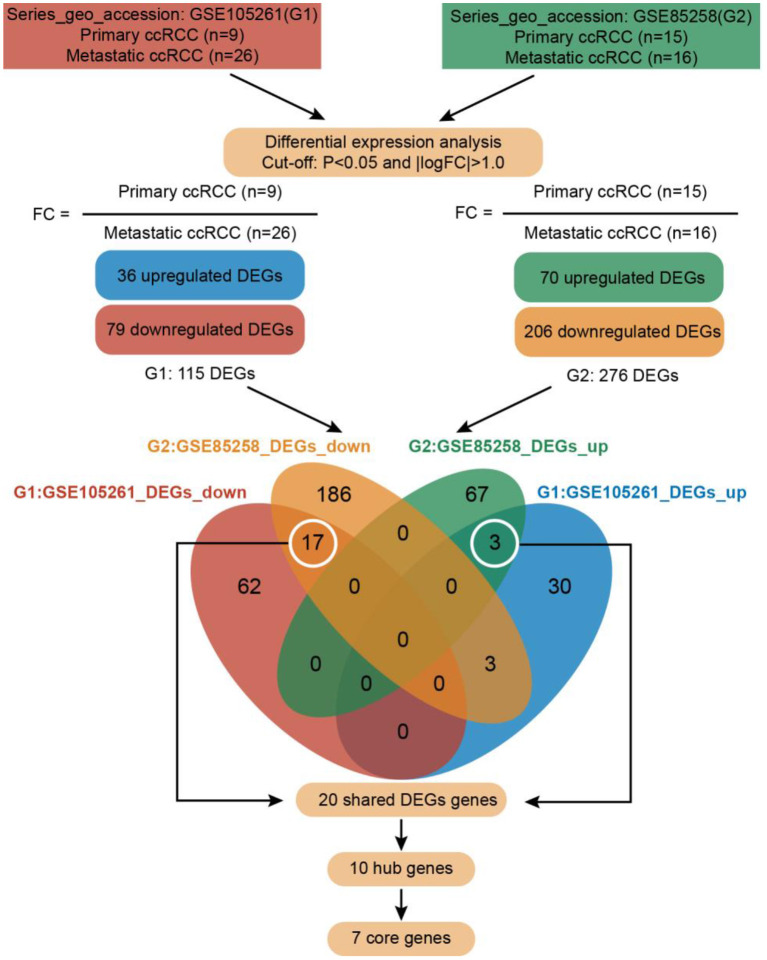
Roadmap of the approach and summarized findings.